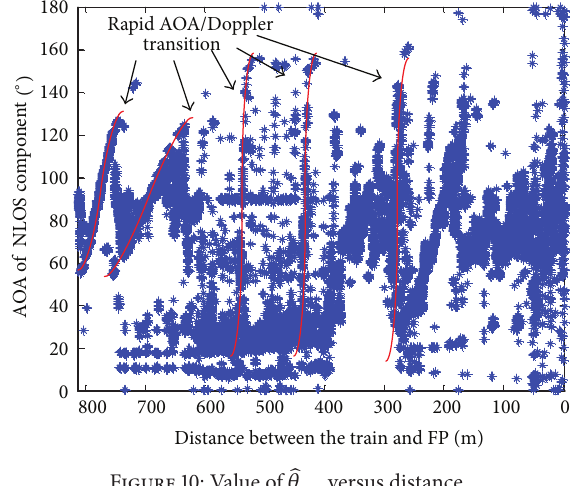
Table 3: Statistical distribution of ̂𝜅